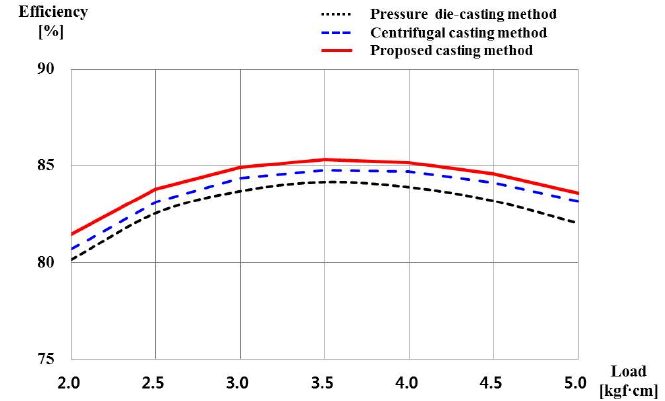
Figure 13. The efficiency of applying the stator #1 (115 V/60 Hz).